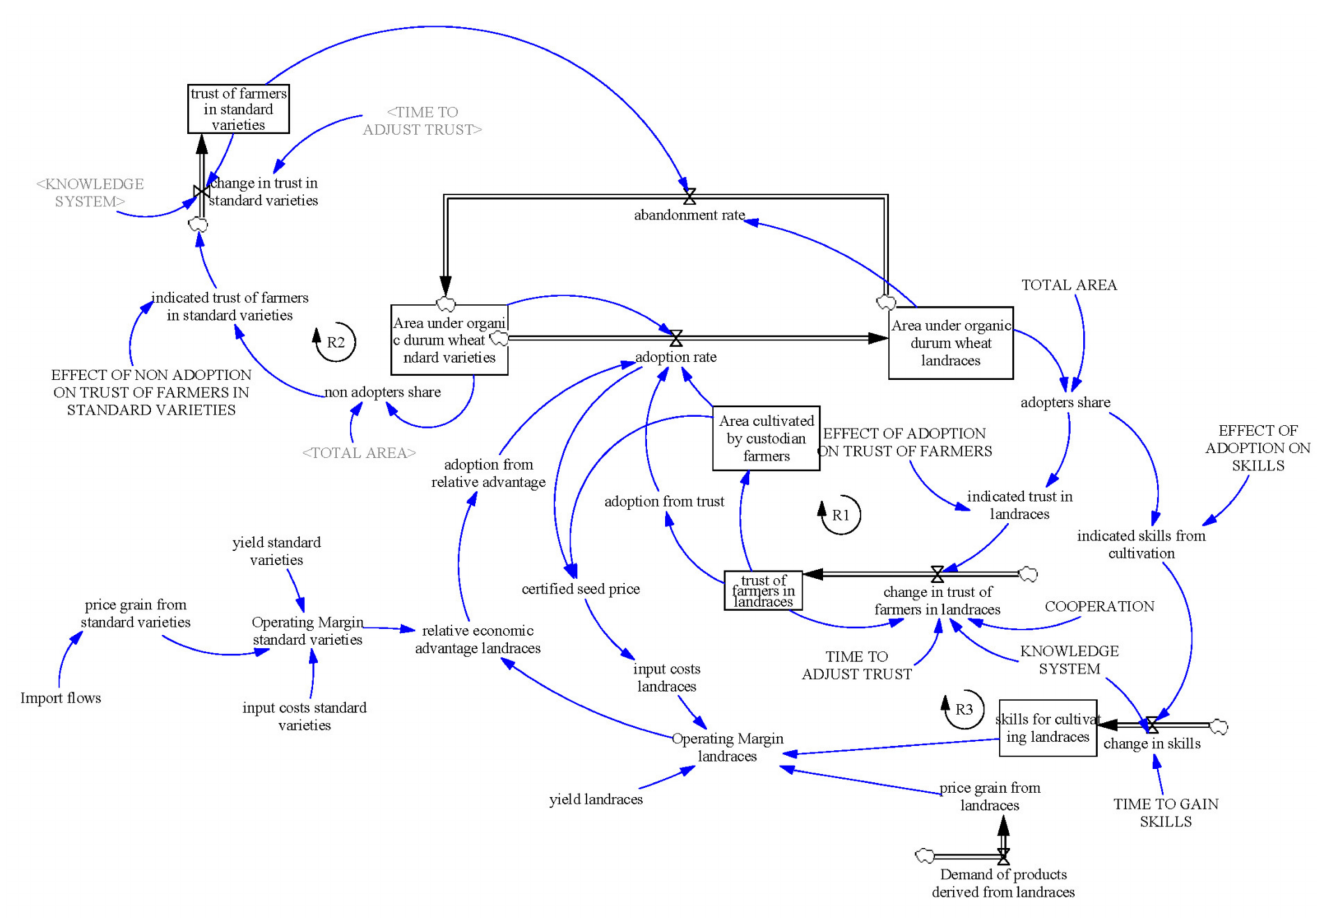
Figure 3. Causal loop diagram.